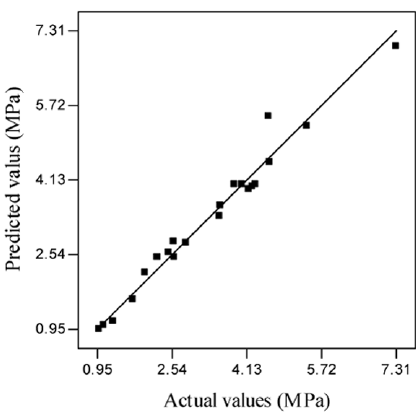
Fig. 8. Predicted and actual values of G*(sin δ)